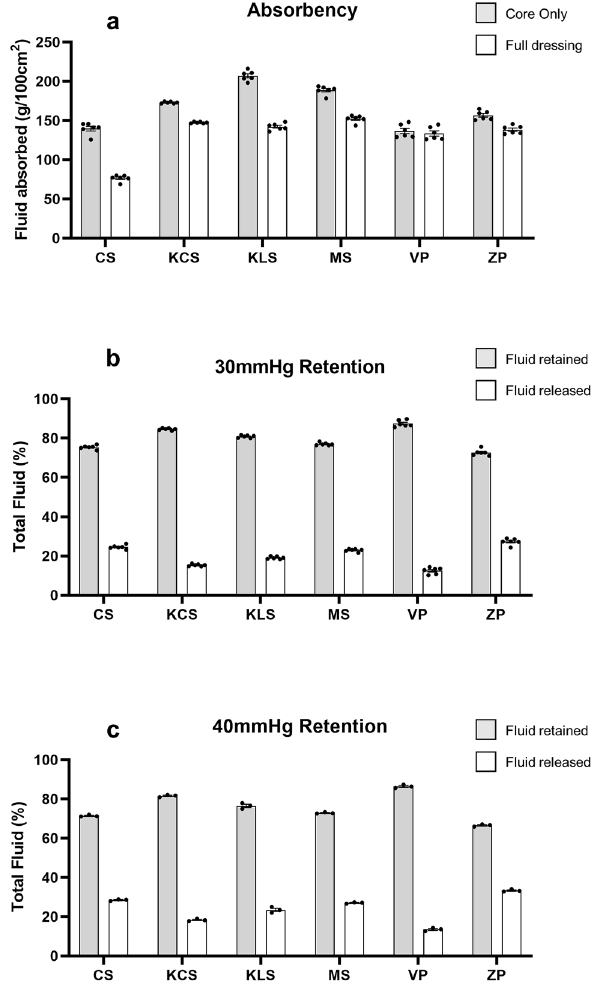
Figure 1. Absorbency and retention of fluid by superabsorbent dressings. Superabsorbent wound dressings were placed into an excess of salt solution. Dressings were weighed after 30 min of soaking at 37 °C and data plotted as g/100 cm 2 ( a ), based on either the size of the inner core or the whole area of the dressing. Pressure, either 30 mmHg ( b ) or 40 mmHg ( c ) relative to pad size, was then applied to each dressing and re-weighed. Data are shown as percentage fluid retained and released. The following dressings were tested: ConvaMax™ Superabsorber (CS), 3M Kerramax Care Super-Absorbent Dressing (KCS), Kliniderm Superabsorbent (KLS), Mextra Superabsorbent (MS), Vliwasorb Pro (VP) and Zetuvit Plus (ZP). Figure produced in GraphPad Prism